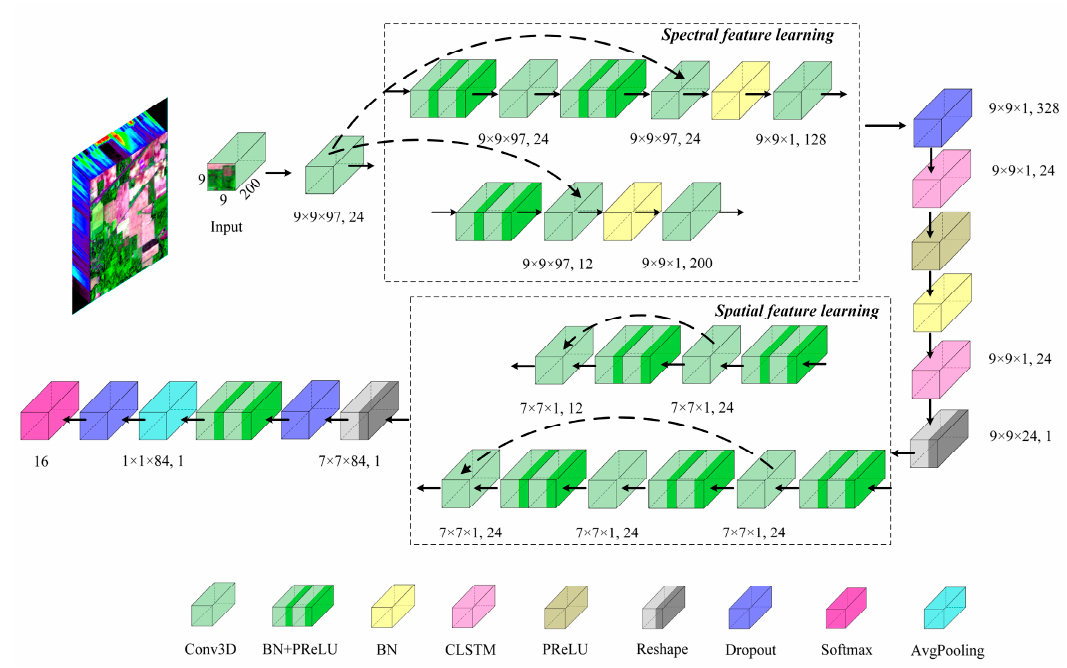
Figure 3. Flowchart of the SSCC network for HSI classification.